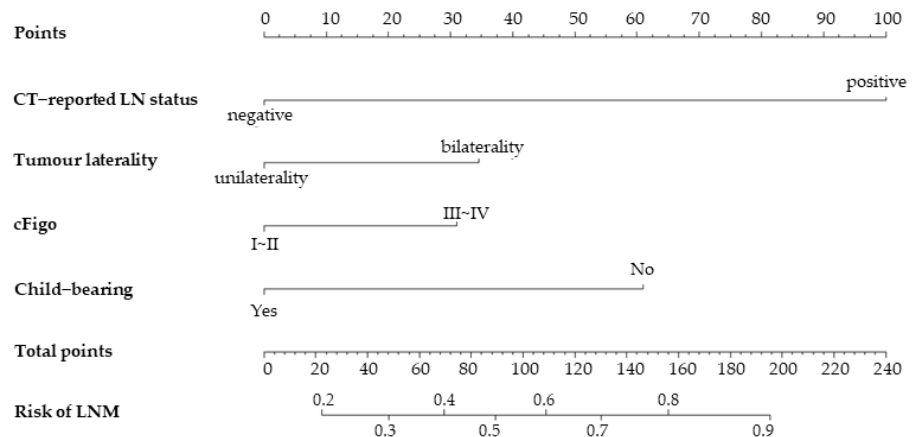
Figure 2. A nomogram combining the CT-reported LN status and clinical variables to identify patients with epithelial ovarian cancer having a high risk of LNM. Abbreviations: CT, computed tomography; LN, lymph node; cFigo, clinical International Federation of Obstetrics and Gynaecology.